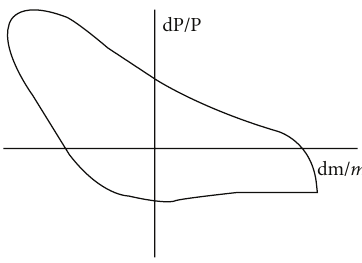
Figure 26: Variation of mass flow rate versus pressure